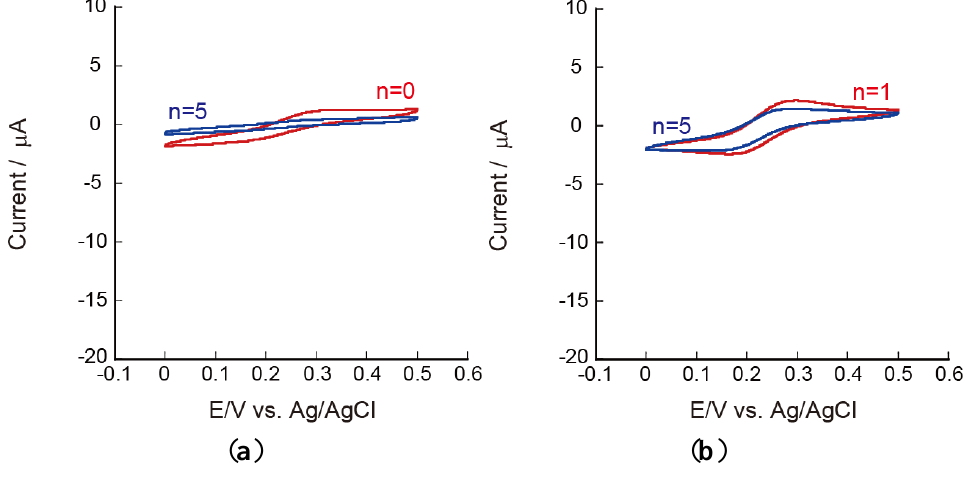
PVS; and ( b ) PEI(PVS/CHI) n